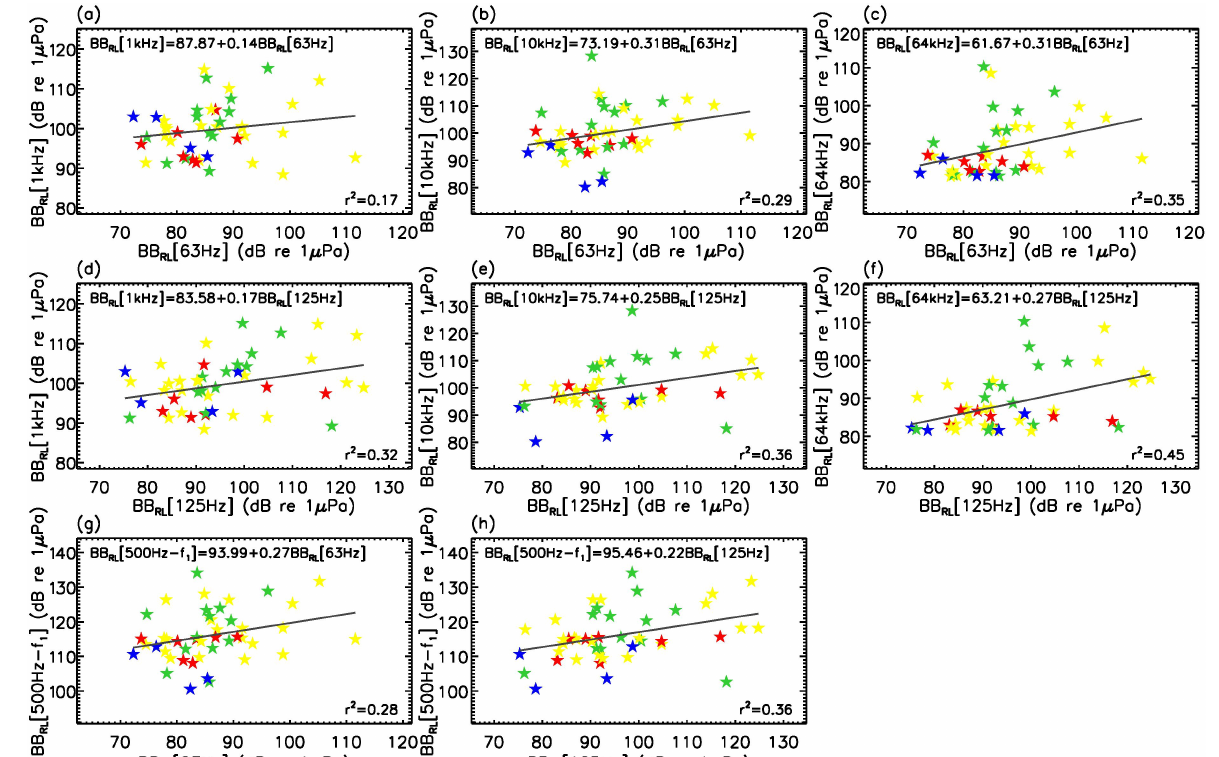
Figure 6. Relationships between received noise levels in the low-frequency 1/3-octave bands, 63 and 125 Hz, and received noise levels in mid-frequency bands for vessels listed in Table 2. BB RL were processed according to the method described in Appendix B with the lower and upper bounds of the summation being provided by each band’s f low and f high values in Table A1. Panels ( a – c ): correlations between the 63 Hz band and 1, 10, and 64 kHz bands. Panels ( d – f ): correlations between the 125 Hz band and 1, 10, and 64 kHz bands. Panels ( g , h ): correlations between the 63 and 125 Hz bands and frequency-integrated broadband between 500 Hz and f 1 (see Section 3.2). Zodiac TM , speedboats, cruisers, and sailboats are respectively coloured in red, yellow, green, and blue. Standard linear regression and corresponding Pearson correlation coefficient are provided, respectively, in the upper-left and bottom-right corners of each